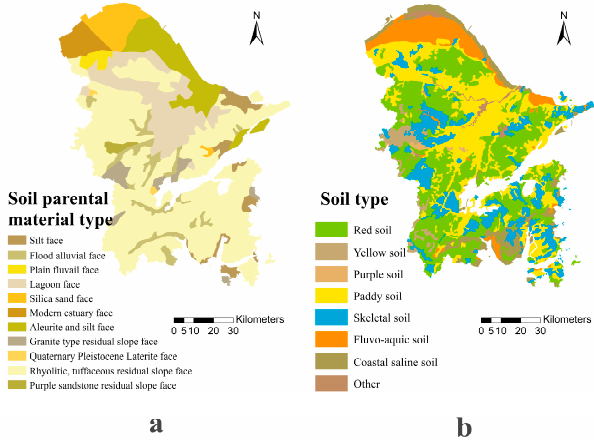
Figure 3. The distribution of the ( a ) soil parent materials and ( b ) soil types in the study area.